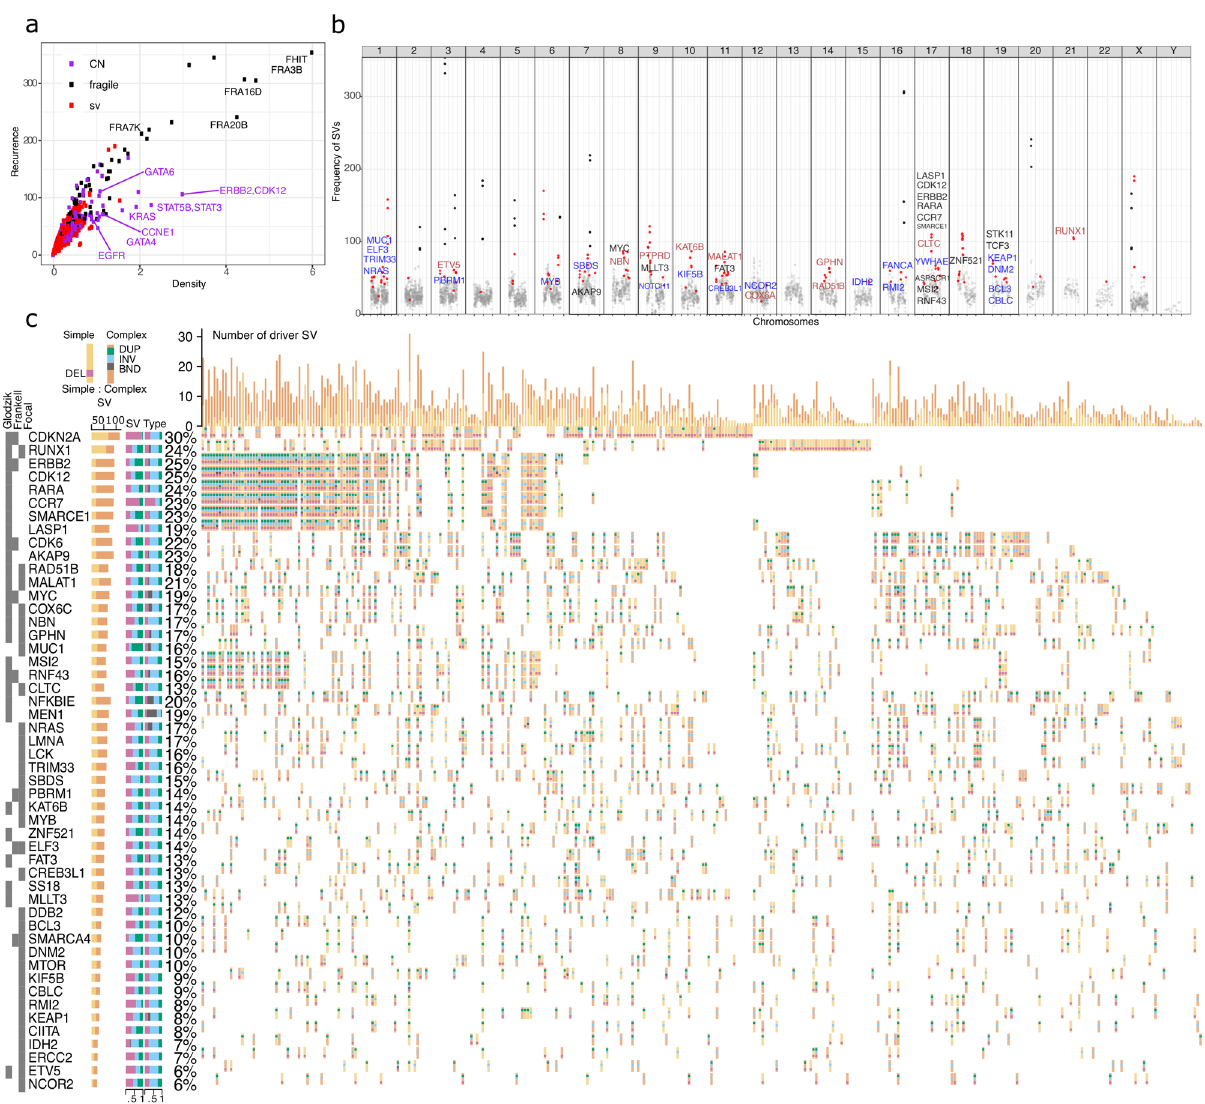
Fig. 4 Recurrence and density of SVs in 1 Mb genomic bins. a Scatter plot showing recurrence, the number of patients with an SV break in each 1 Mb bin ( y -axis) and density, the average number of SV breaks in the bin over all tumours ( x -axis). Bins are labelled with genes or fragile sites that they overlap: black, fragile sites; purple, intervals of ampli fi cation and deletion; red, putative genes under selection. b Manhattan plot showing 1MB bins containing putative drivers (red) and fragile sites (black) and genes coloured by methods discovered: Glodzik model adjusting for genomic context (Black), Focal (F, blue) and both methods (brown: FG). c Oncoplot showing candidate driver genes identi fi ed using focal and Glodzik methods and annotated if each gene was found in Frankell et al. (2019). Horizontal bar plots show total number of simple (light orange) and complex (dark orange) SVs found in the given gene; proportions of SVs classi fi ed as simple that are of the various SV types; and similarly for SVs classi fi ed as complex. Each oncoplot cell shows if each patient has a simple or complex SV and the combination of SV